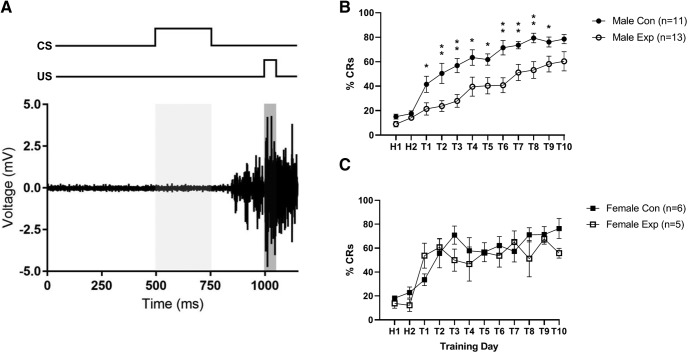
Trace eyeblink conditioning in mice. A, EMG activity from an animal trained on tEBC (bottom trace), depicting a well timed CR. The timing of the CS (whisker vibration) and US (air puff) presentation are shown at the top of the panel. B, C, Learning curves for the male (B) and female (C) control and experimental groups. Average percentage CRs are shown for each day, where “H” refers to days of habituation and “T” refers to days of training. Error bars represent the SEM. Post hoc t tests were used to test statistical differences for each day of training (*p < 0.05; **p < 0.01).